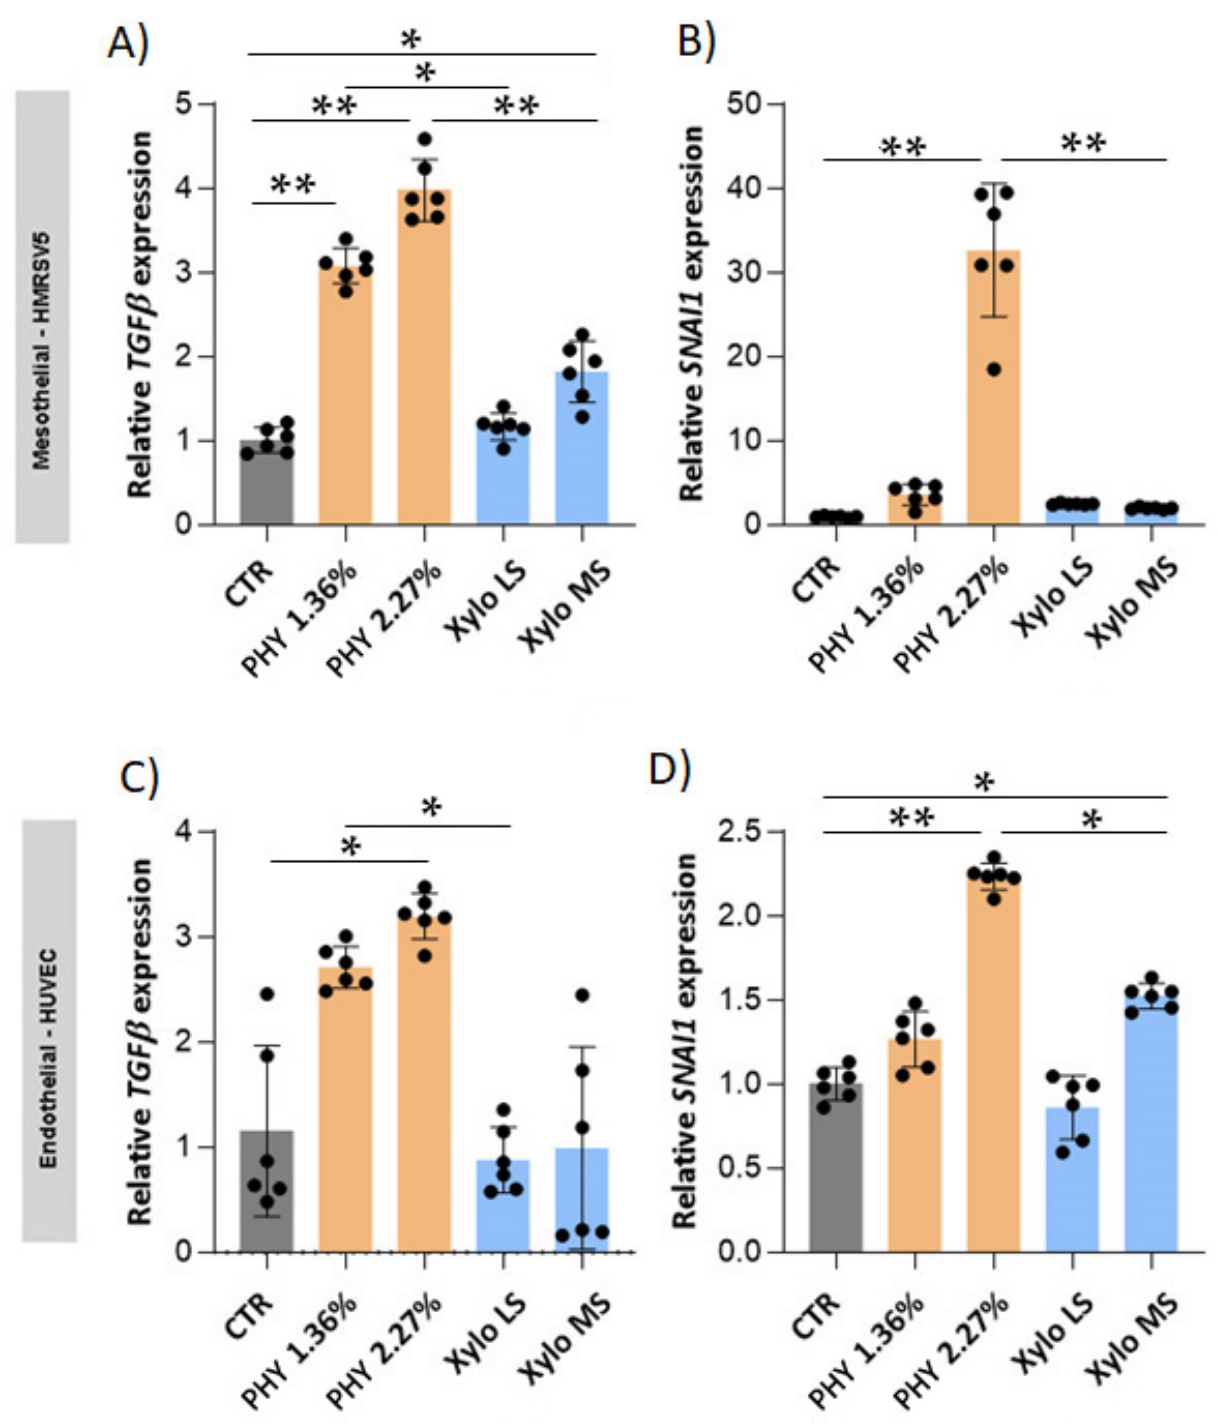
Figure 5. SNAI1 and TGF- β expression in mesothelial and endothelial cells. TGF- β ( A , C ) and SNAI1 ( B , D ) gene expression was quantified by real-time PCR. The analysis was performed in HMRSV5 mesothelial cells ( A , B ) and in HUVEC endothelial cells ( C , D ) treated for 3 h in PD or control solution and then recovered with complete medium for 24 h. The results were normalized using ACTIN as an internal control and represent the mean ± S.D. (error bars) ( n = 6 biological replicates). ( A ) CTR vs. PHY 1.36% p < 0.0001, CTR vs. PHY 2.27% p < 0.0001, CTR vs. Xylo MS p = 0.0026, PHY 1.36% vs. Xylo LS p = 0.0019, PHY 2.27% vs. Xylo MS p < 0.0001; ( B ) CTR vs. PHY 2.27% p < 0.0001, PHY 2.27% vs. Xylo MS p < 0.0001; ( C ) CTR vs. PHY 2.27% p = 0.0053, PHY 1.36% vs. Xylo LS p = 0.0016; ( D ) CTR vs. PHY 2.27% p < 0.0001, CTR vs. Xylo MS p = 0.0095, PHY 2.27% vs. Xylo MS p = 0.0016. * p < 0.05, ** p < 0.001. Activation of the MMT program is characterized by the expression of mesenchymal markers and the down-regulation of epithelial protein. HMRSV5 mesothelial cells exposed to glucose-based PD solutions exhibited a significant up-regulation of mesenchymal markers α -SMA and VIM , as well as E-CAD , a key epithelial marker, both at gene (Figure 6A–C) and protein (Figure 6D) levels. The treatment with XyloCore only slightly increased the expression of mesenchymal markers without affecting E-CAD